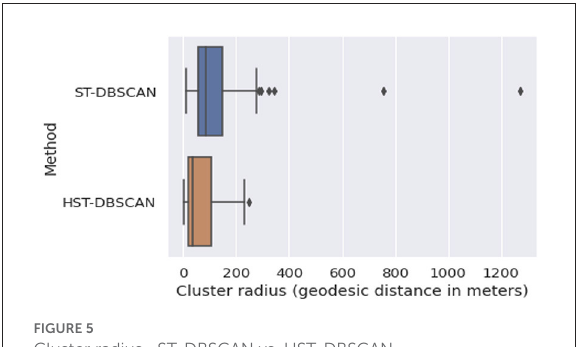
FIGURE5 Cluster radius—ST-DBSCAN vs. HST-DBSCAN.